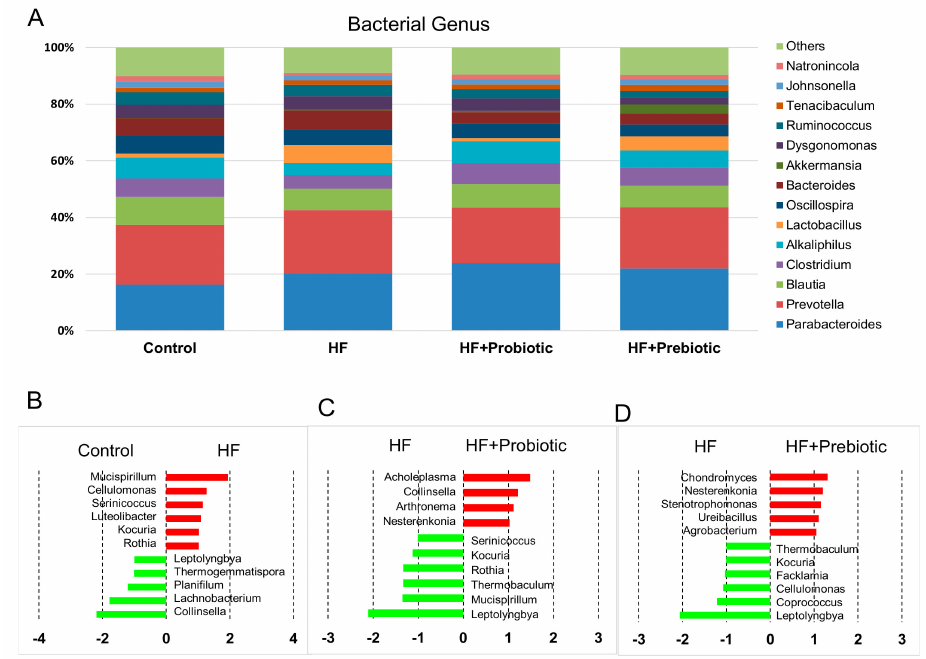
Figure 4. Effect of maternal high-fructose (HF) diet, probiotic Lactobacillus casei , and prebiotic inulin on gene expression of ( A ) relative abundances of the gut microbiota at the genus level. Linear discriminant analysis (LDA), along with effect size measurements, was applied to identify enriched bacterial genera. Most enriched and depleted genera (LDA score (log10) > 1.0) in the ( B ) HF (red) vs. control (green), ( C ) HF+Probiotic (red) vs. HF (green), and ( D ) HF+Prebiotic (red) vs. HF (green). N =